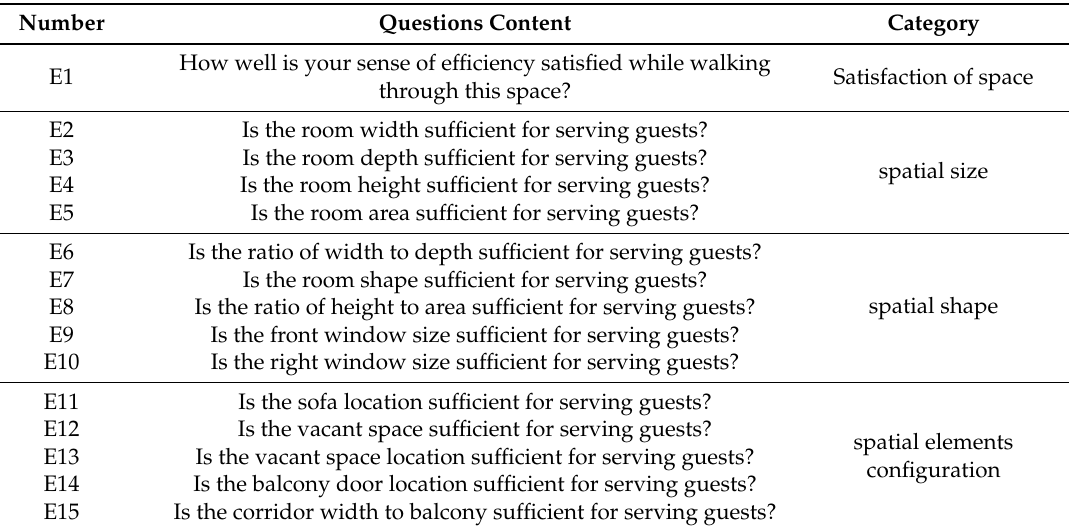
Table 4. Contents of questionnaire for efficiency